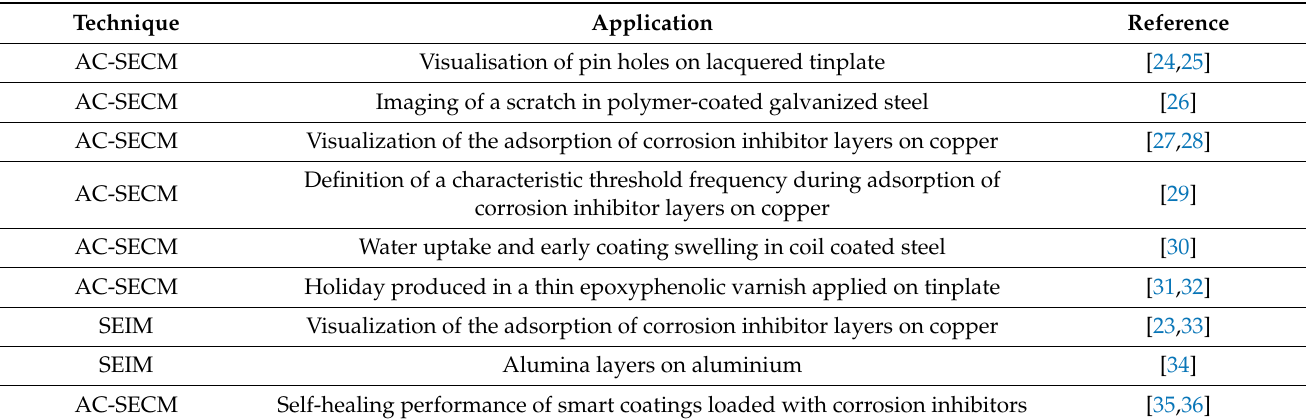
Table 1. Selected summary of successful applications of AC modes in SECM for the investigation of thin surface layers and coatings on